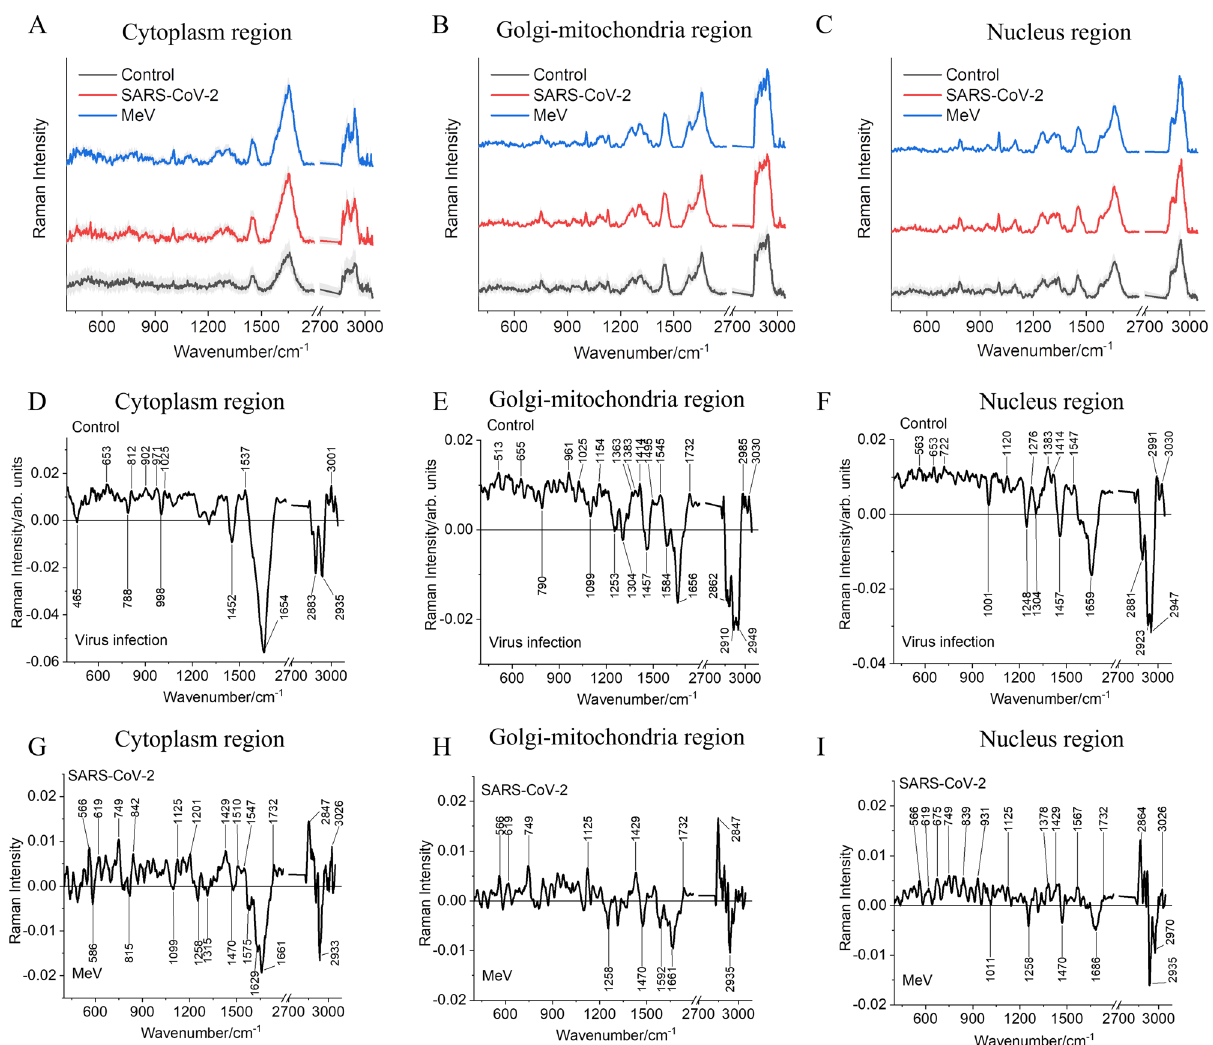
Fig. 2 Mean Raman spectra from the cytoplasm, Golgi-mitochondria bodies, and nucleus region shown for noninfected (Control) and infected Vero E6 cells (SARS-CoV-2 and MeV) along with the standard deviation. A Raman spectra were extracted from the cytoplasm region, B Raman spectra were extracted from Golgi-mitochondria bodies, and C Raman spectra were extracted from the nucleus region. D – F Difference Raman spectra calculated between noninfected (Control) and virus-infected cells (MeV and SARS-CoV-2 taken together) for D cytoplasm, E Golgi-mitochondria, and F nucleus region of the Vero E6 cells. G – I Difference Raman spectra calculated between the SARS-CoV-2-infected cells and MeV-infected cells and for G cytoplasm, H Golgi-mitochondria, and I nucleus region of the Vero E6 cells. The difference Raman spectra have been smoothed using the Savitzky – Golay method with points of window 15 and polynomial order 2. The Raman spectra are shifted on the y-axis for sake of